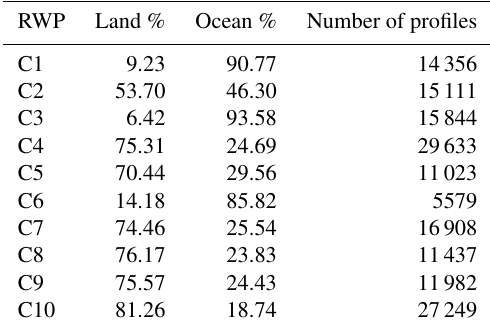
Table 1. RWPs, showing the percentage that occur over land and ocean and the total number of profiles in each